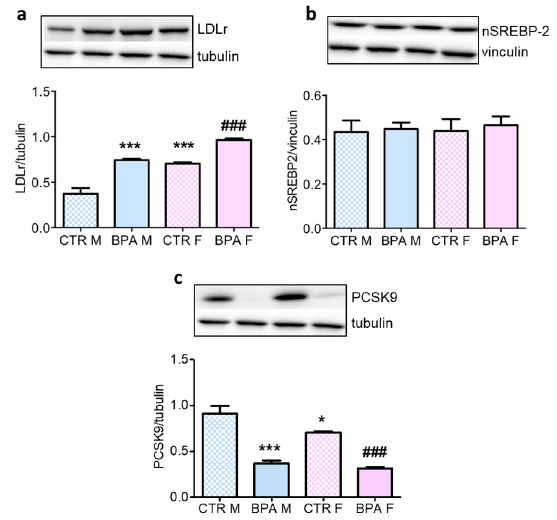
Figure 5. LDLr, nSREBP2 and PCSK9 content in the brain of rat fetuses in utero exposed to 2.5 µg/kg/day of BPA. Representative Western blot and densitometric analysis of LDLr ( a ), nSREBP2 ( b ) and PCSK9 levels ( c ). n = 6 for each experimental group. Tubulin or vinculin served as housekeeping proteins. Statistical analysis was carried out by using two-way ANOVA followed by Bonferroni post-hoc test. * = p < 0.05 vs. CTR M; *** = p < 0.001 vs. CTR M; ### = p < 0.001 vs. CTR F.